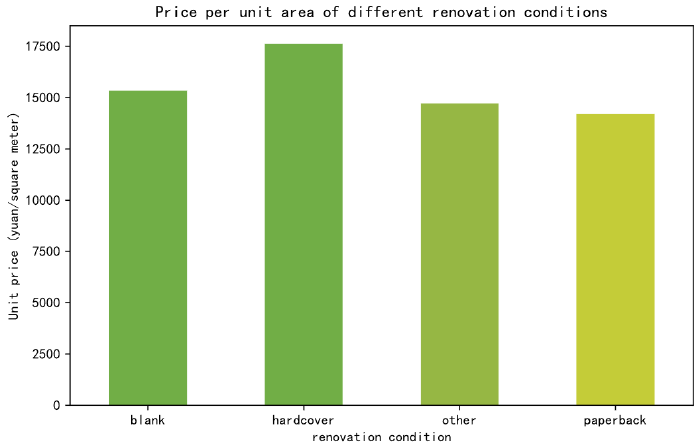
Fig. 8 House prices per unit area in various decoration conditions